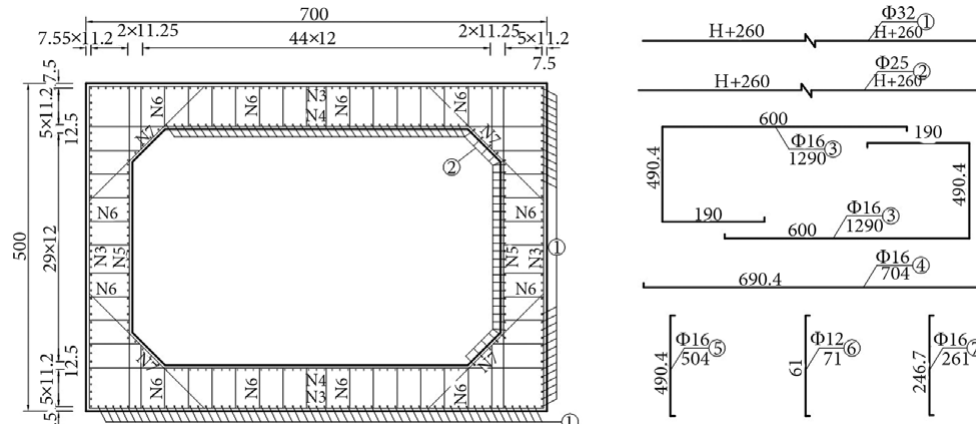
Fig. 13. Rectangular hollow cross section configurations and steel